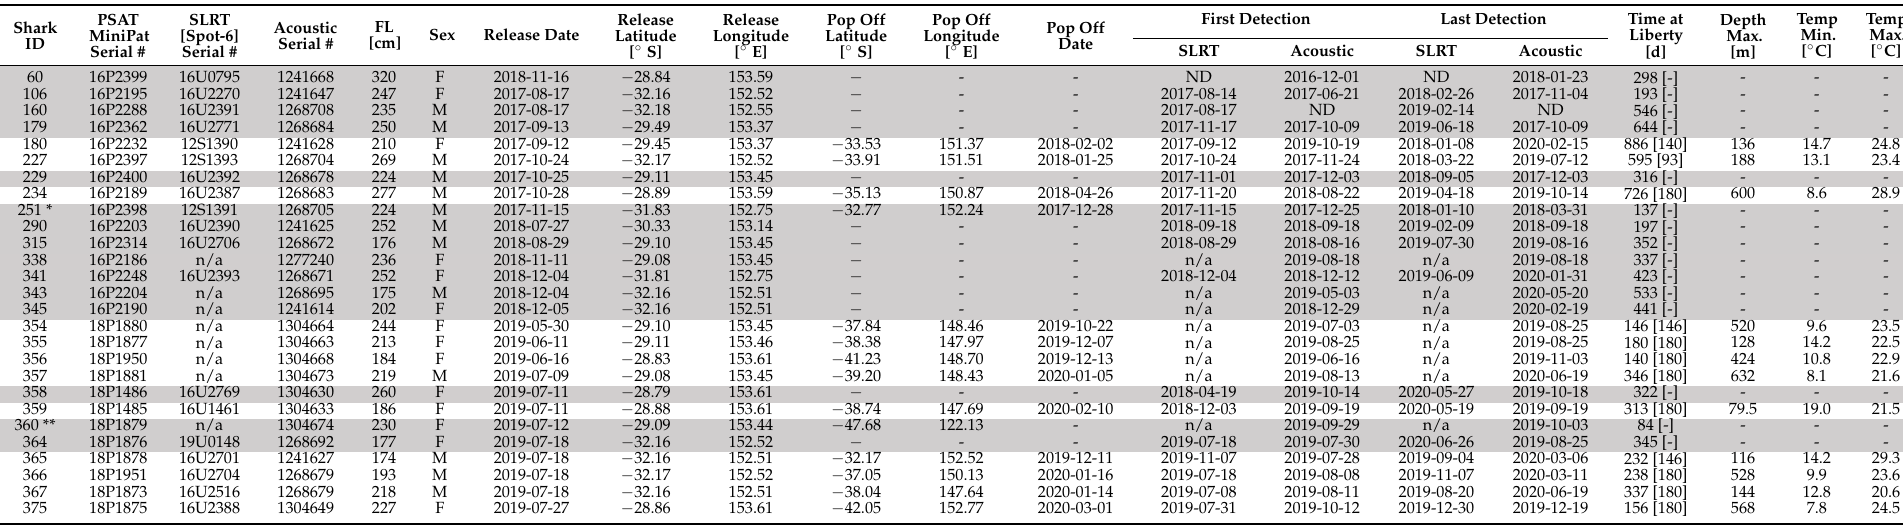
Table 1. Details and tracking periods of 27 tagged white sharks. Total time at liberty refers to the time period between the date of tagging and last detection by any of the three tag types (MiniPat tags [PSAT]; Spot–6 tags [Satellite Linked Radio Transmitting tags—SLRT]; acoustic tags), values in brackets indicate tracking period of successful PSAT deployments. FL: fork length; n/a: not applicable (shark was not fitted with tag type). ND: No detections recorded. Shading indicates sharks that were excluded from the analysis due to failed PSAT reporting; * spontaneous deletion of archive after tag was retrieved; ** only one